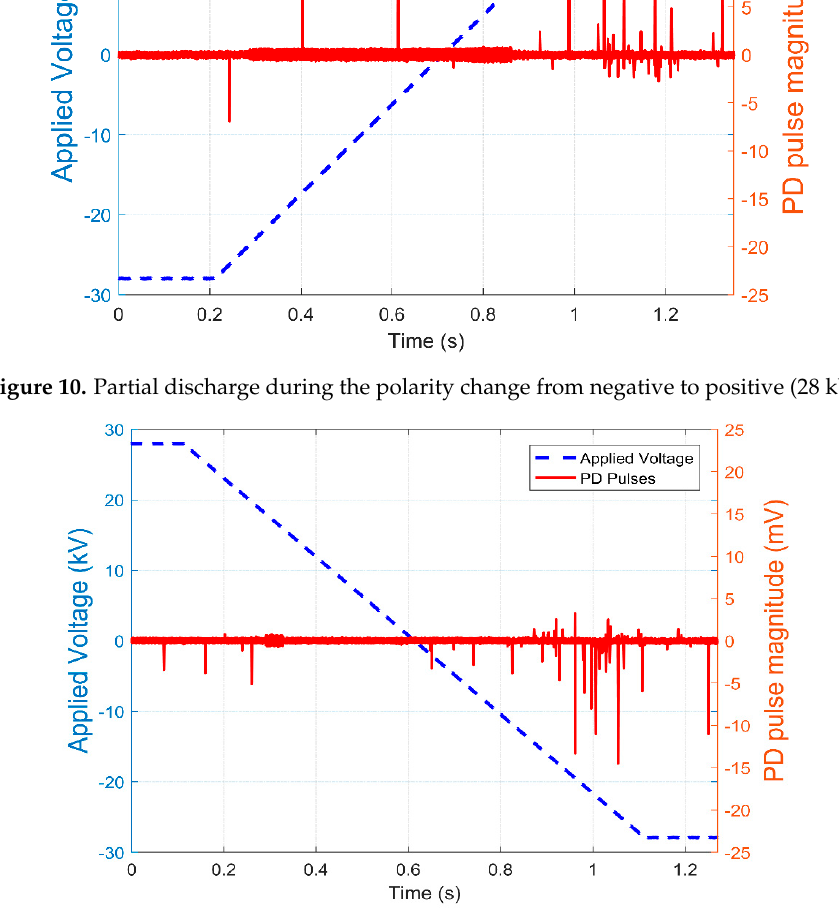
Figure 11. Partial discharge during the polarity change from positive to negative (28 kV).